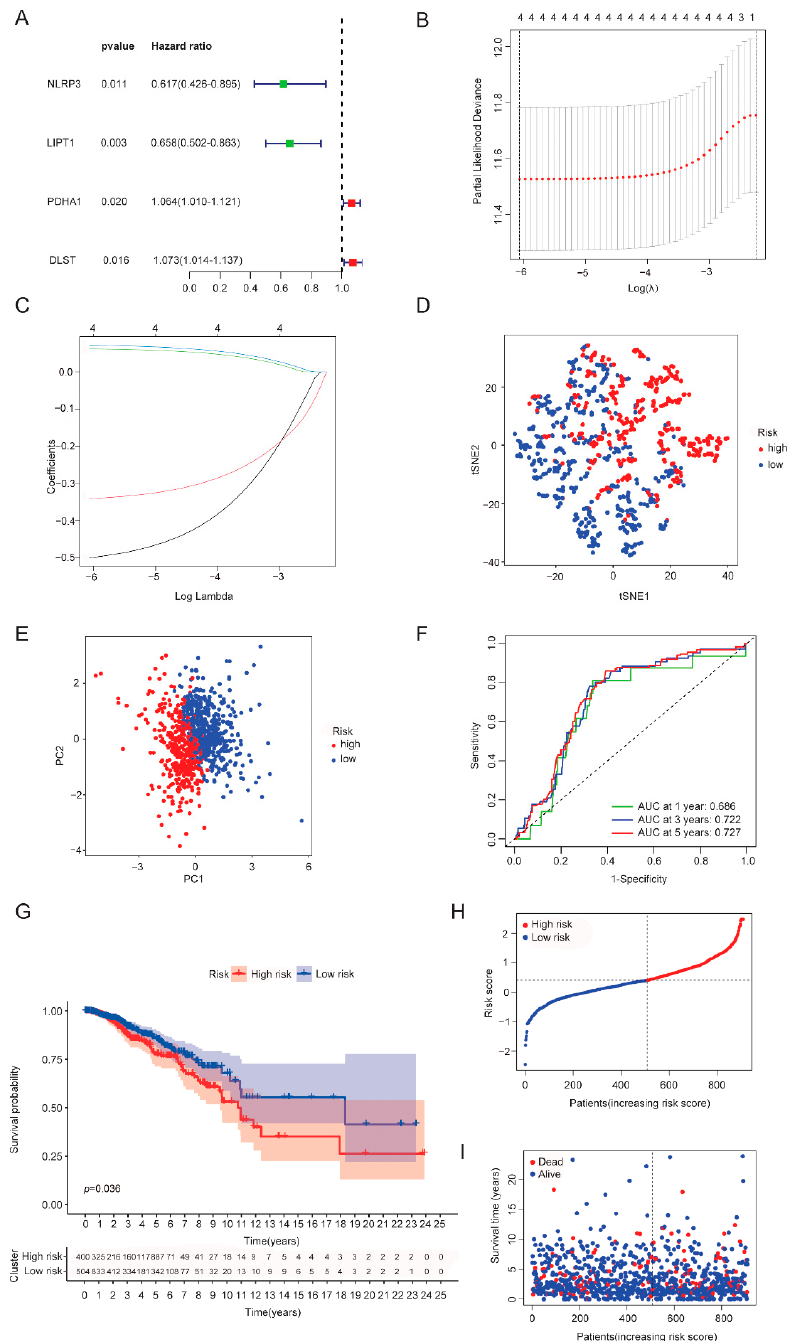
Figure 4. Identification of the CRGs risk model in the training set (TCGA cohort). ( A ) Forest plot of multi ‐ variate cox regression analysis for each cuproptosis gene, and four candidate genes with p < 0.05. ( B ) Partial likelihood deviance plot of LASSO regression for four candidate genes. ( C ) Cross ‐ validation for four OS ‐ related genes in the LASSO regression (Different color lines represent different genes: black line (NLRP3), red line (LIPT1), green line(PDHA1) and blue line(DLST). ( D ) tSNE plot for BRCA patients based on the risk score. ( E ) PCA plot for BRCA patients based on the risk score. ( F ) ROC curve analysis demonstrated the predictive efficiency of the risk score. ( G ) Kaplan–Meier curve analysis for the OS of patients in the two risk groups. ( H ) Distribution of patients according to the median risk score. ( I ) The survival status distribution for each patient of a different risk